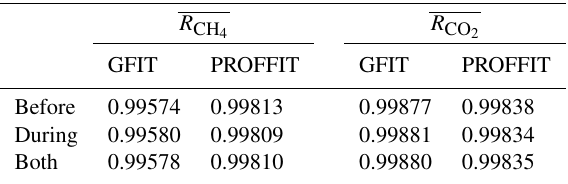
Table 1. Calibration factors R G for X CH during the field campaign, determined by forcing a linear regression line to go through the origin. R G for X CH using all data, are provided in the last row and used for the field study.